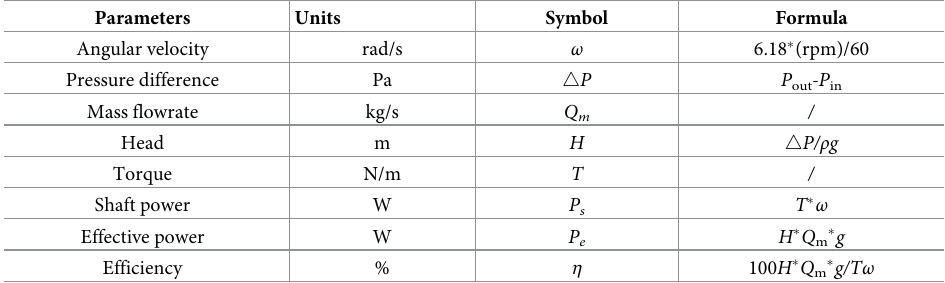
Table 4. Monitoring parameters and calculation formulas for hydraulic performance evaluation.